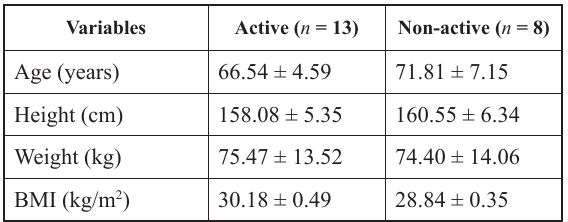
Table 1. Basic descriptive physical parameters (means ± standard deviations)